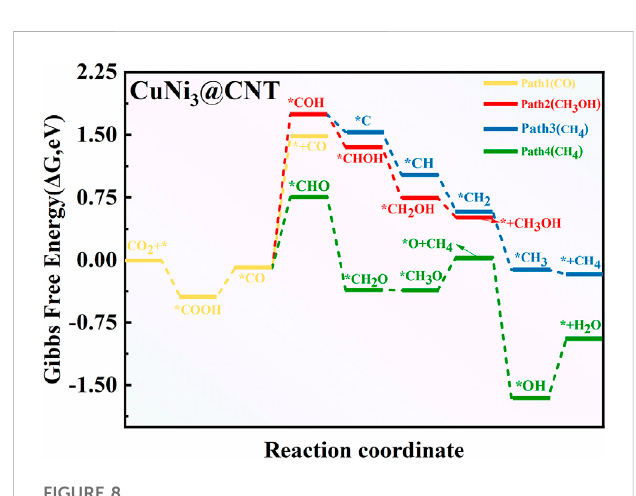
Free energy diagram of CO 2 RR on CuNi 3 were determined on CuNi 3 @CNTs. The free energy and geometric structure diagrams are shown in Figures 8, 9, respectively. The *COOH intermediate is obtained in the fi rst step of hydrogenation